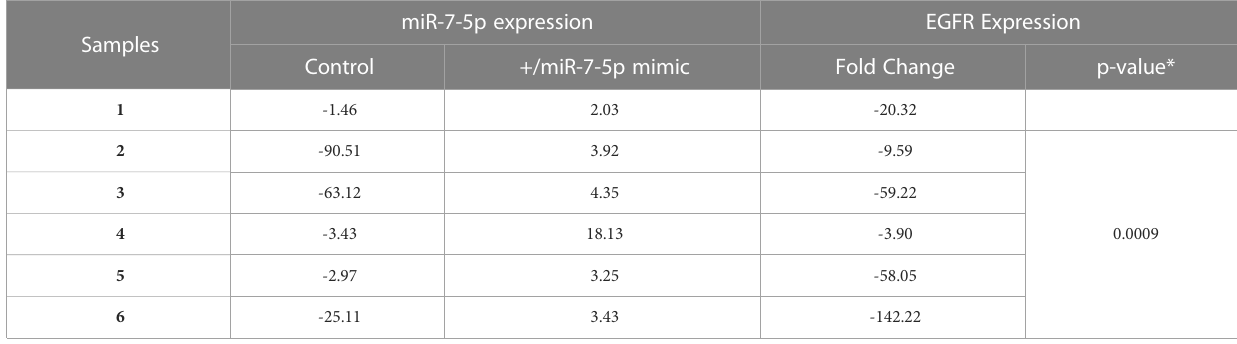
TABLE 4 Effect of miR-7-5p mimic on EGFR mRNA expression in PTC.